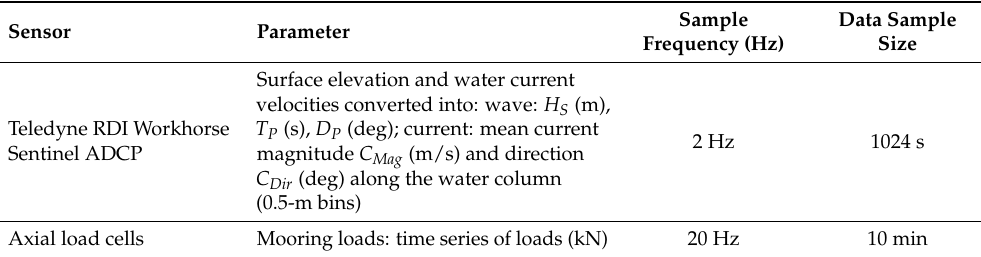
Table 1. Summary of instrumentation at SWMTF.